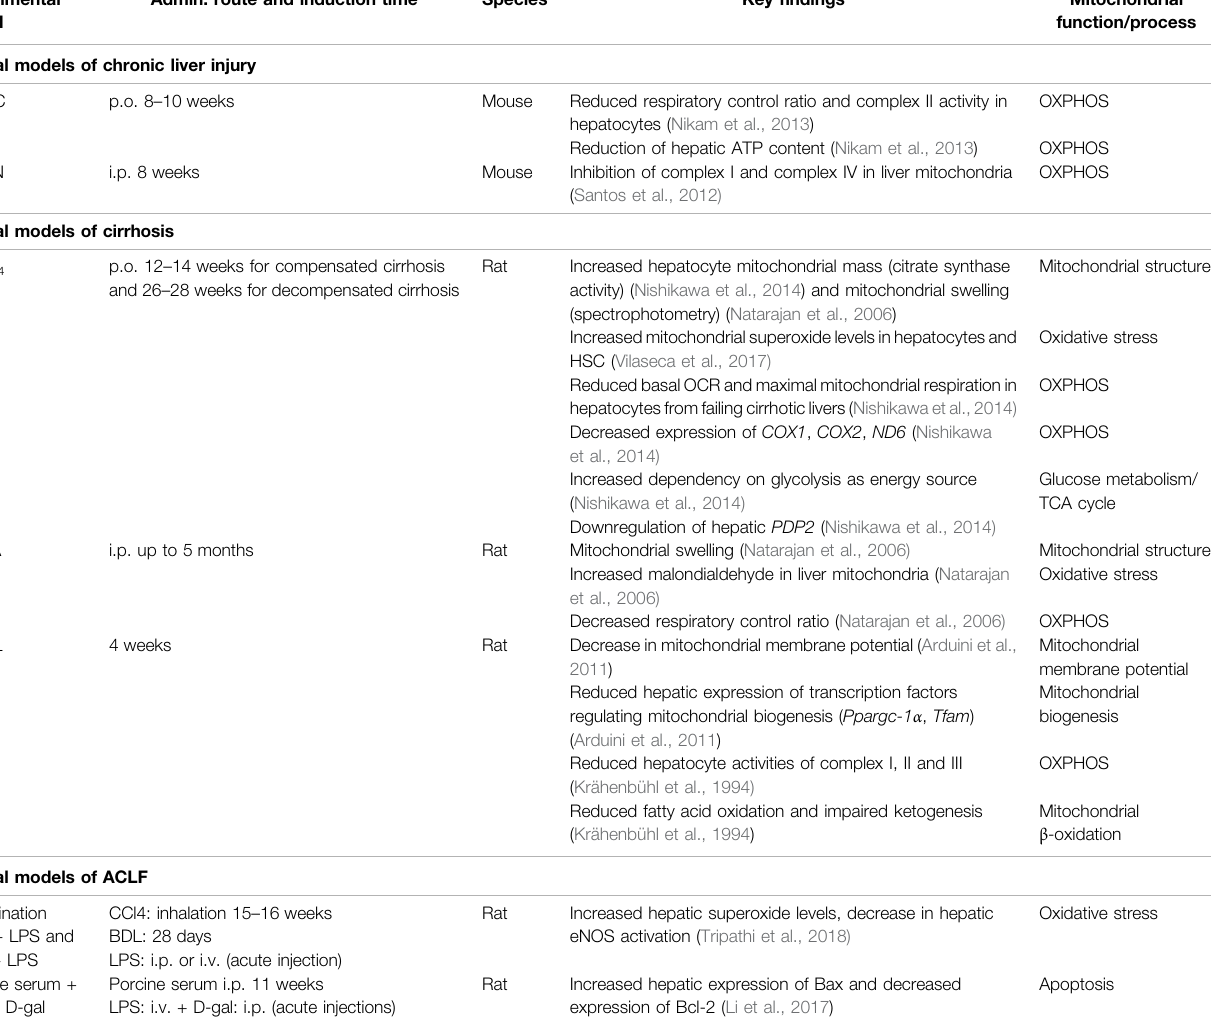
TABLE 2 | Overview of different animal models of chronic liver injury, cirrhosis and ACLF and fi ndings related to mitochondrial functionality. Experimental